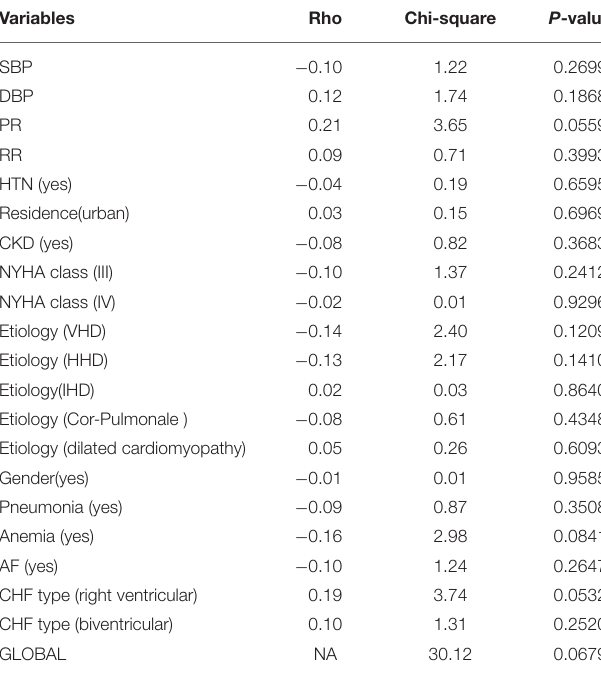
TABLE 4 | Proportional hazard model assumption of the Cox model for patient data with CHF at three selected hospitals from 2015 to 2020.